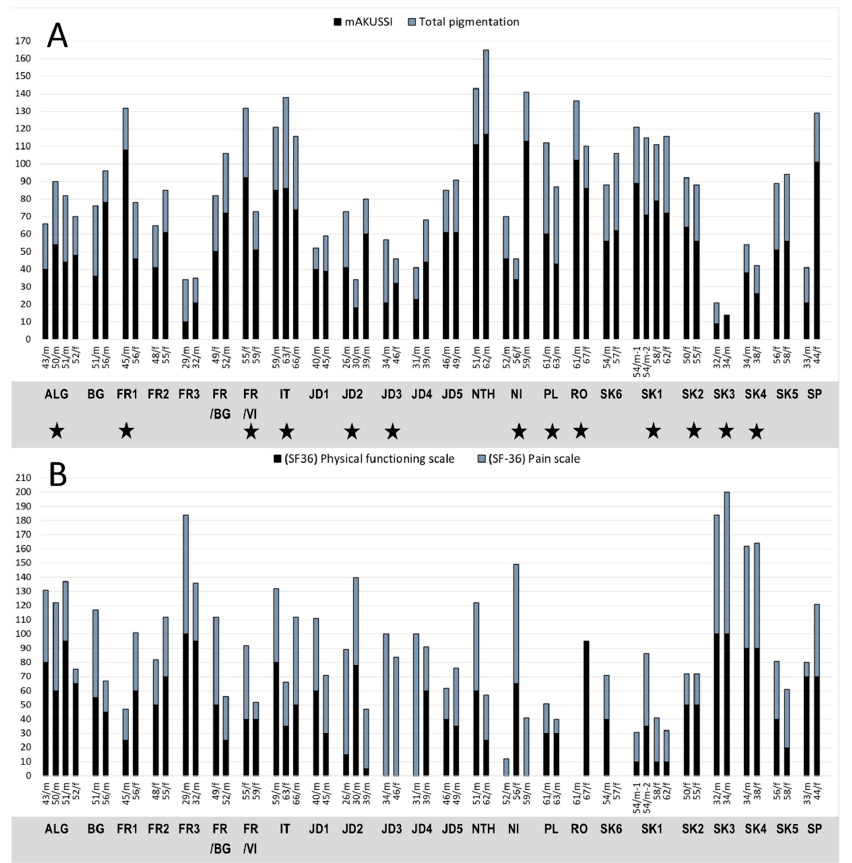
Figure 1. Comparison of ( A ) cAKUSSI (sum of mAKUSSI and total pigmentation), and ( B ) the physical functioning and pain scales from the self-administered SF-36 questionnaire in the siblings analyzed in our study. Age and sex are shown (m-male, f-female), the younger sibling is always to the left. Individual sibling groups are separated by a gap. Generally, an increase in cAKUSSI score indicates a worsening of the disease manifestations and this increases with age ( A ). In families marked by star the cAKUSSI score was higher in a younger sibling. In the SF-36 questionnaires ( B ), a score of 100 indicated no symptoms, whereas 0 indicated extreme symptoms; thus, the lower the score the more